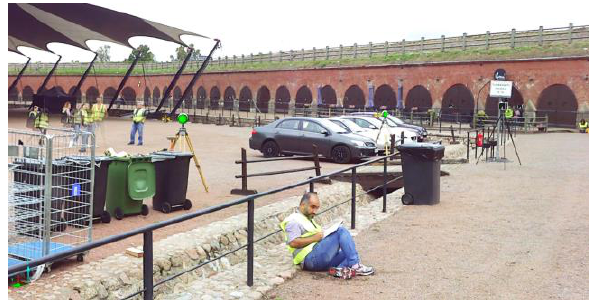
Figure 10. 2D Laser Scanning data image obtained in the